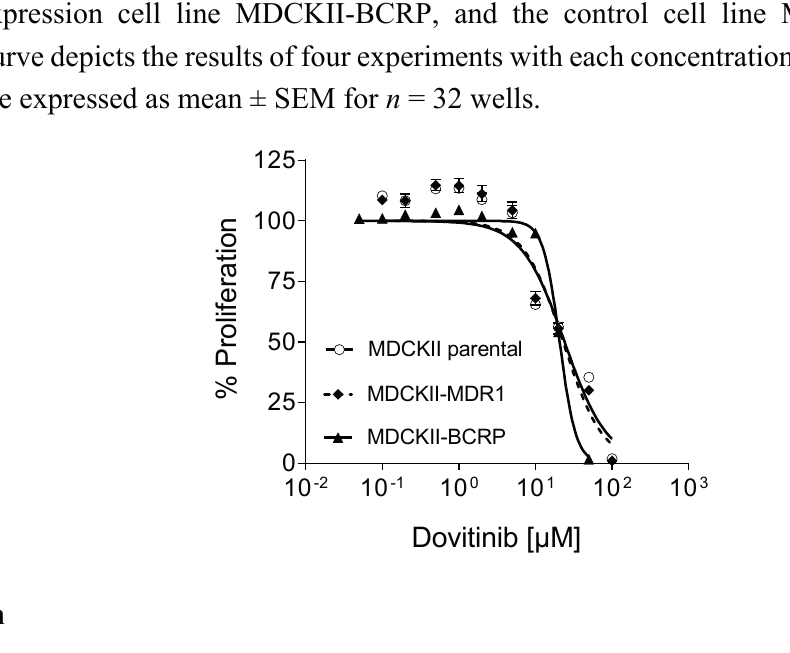
Figure 6. Growth inhibition assay. Concentration-dependent effect of dovitinib (0.1–100 µM) on the proliferation of the P-gp over-expressing cell line MDCKII-MDR1, the BCRP over-expression cell line MDCKII-BCRP, and the control cell line MDCKII parental. Each curve depicts the results of four experiments with each concentration tested in